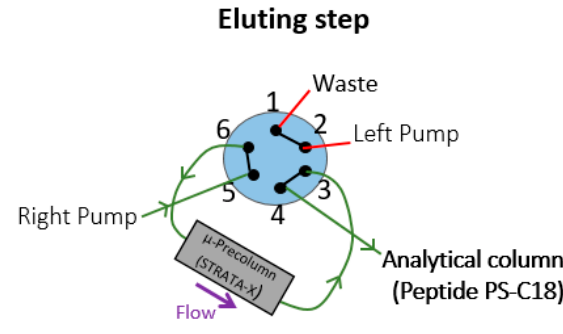
Figure 8. Switching valve used with the LC-MS/HRMS device to clean-up the sample.